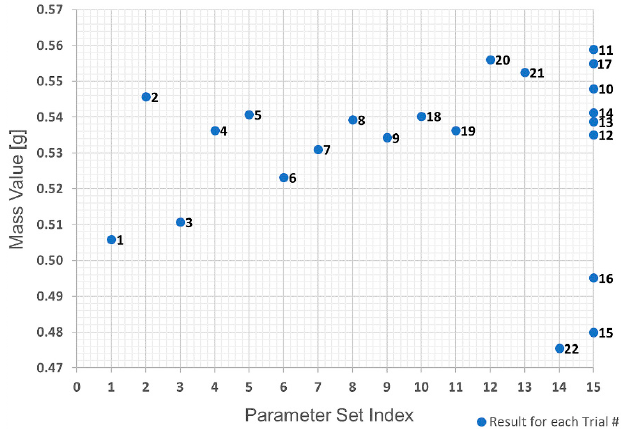
Figure 22. Replicate plot: average mass value for each trial number